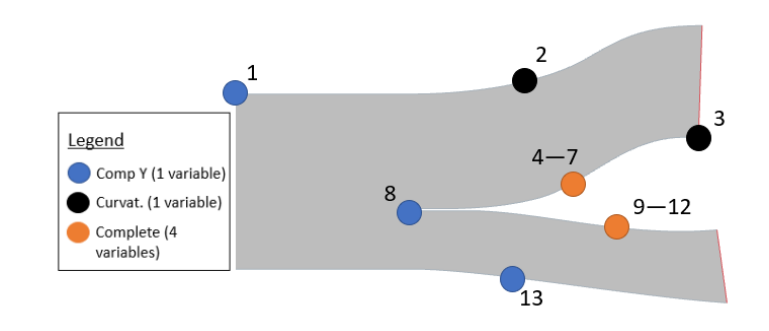
Figure 8. Control variables of the Taguchi optimization